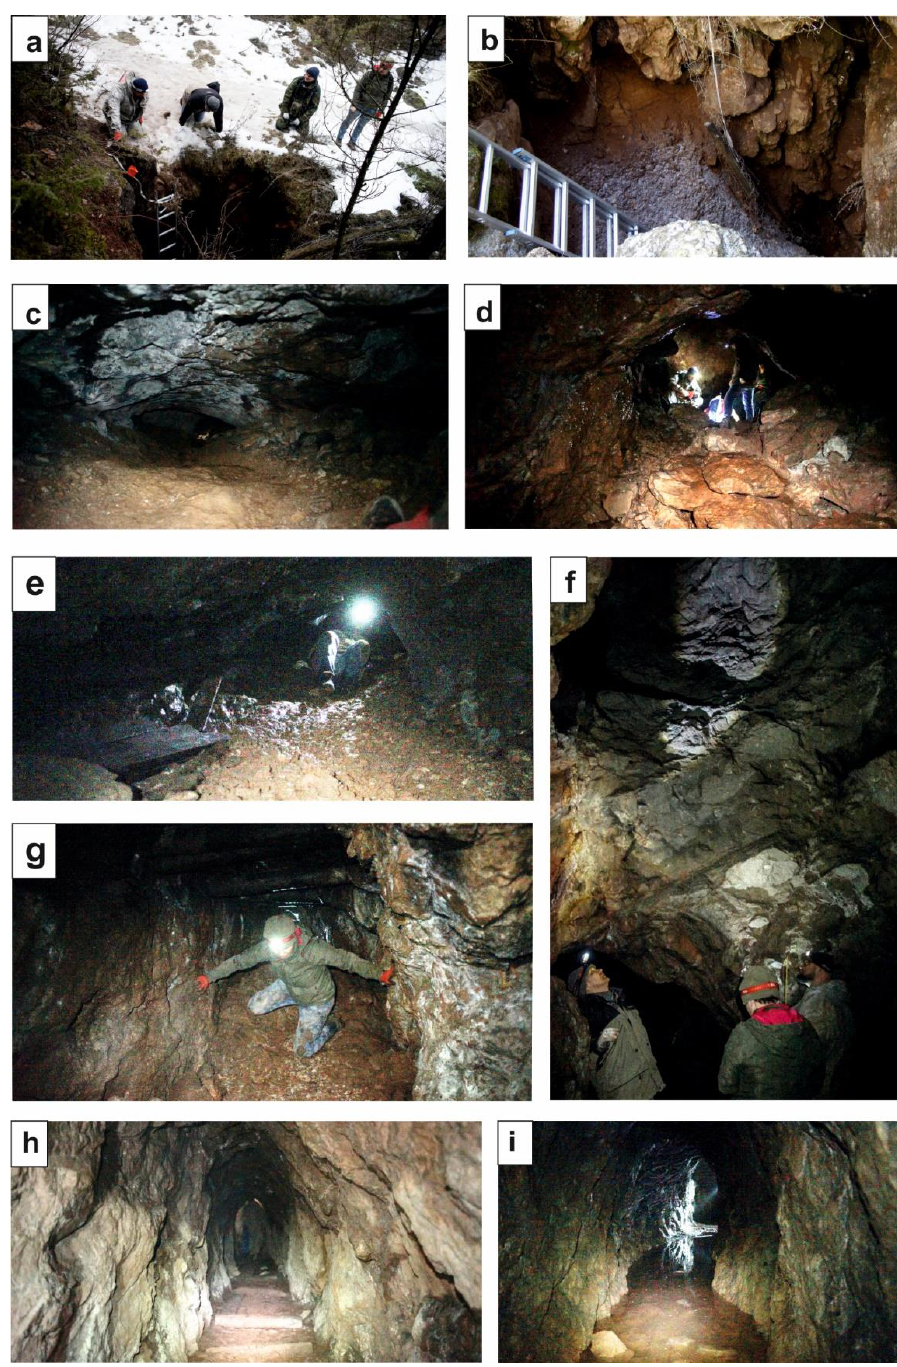
Figure 5. Underground photos from the exploration of the Teresa adit: ( a ) the entrance to the Teresa adit in the bottom of the abandoned quarry on the eastern slope of the Miedzianka Mountain; ( b ) close-up view of the entrance–chimney, carved within Devonian limestones; ( c ) small and low chamber in a natural part (cave) of the adit with waste rock heap, site P1; ( d ) small chamber in natural part (cave) of the adit with rock debris and heap waste rock, site P3; ( e ) small chamber in natural part (cave) of the adit with visible wood remnants after mining activities, site P4; ( f ) large chamber in a natural part (cave) of the adit developed within the tectonic breccia zone, P4; ( g ) underground workings with remnants of wood elements in the ceiling, area between sites P4 and P5; ( h ) underground workings with remnants of wood sleepers—the beams support the track of the railway transporting the excavated material on the floor; note the regular shape of walls and semi-oval shape of ceiling, site between P5 and P6; and ( i ) flooded underground gallery in east direction from site P6 and P7 (not explored in this study).